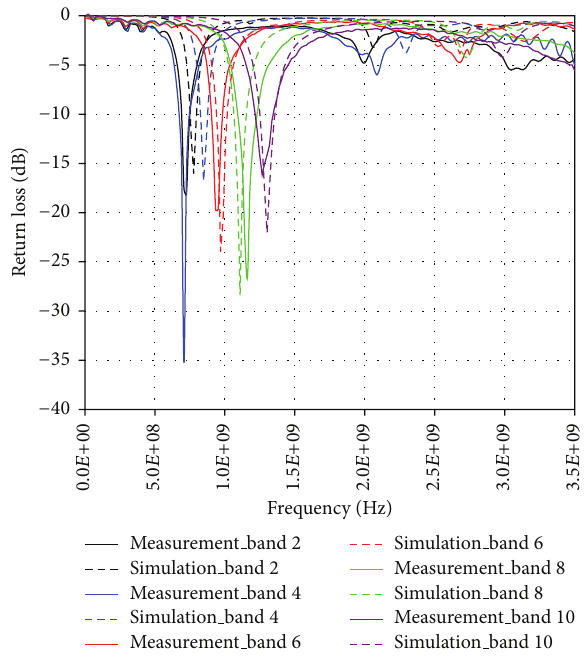
Figure 3: Simulated and measured return losses at Bands 1, 3, 5, 7, and 9.